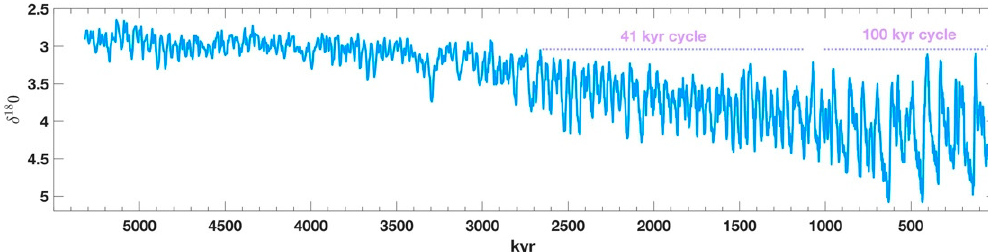
Figure 1. Temperature as a function of time during the last 5,500,000 years [31].